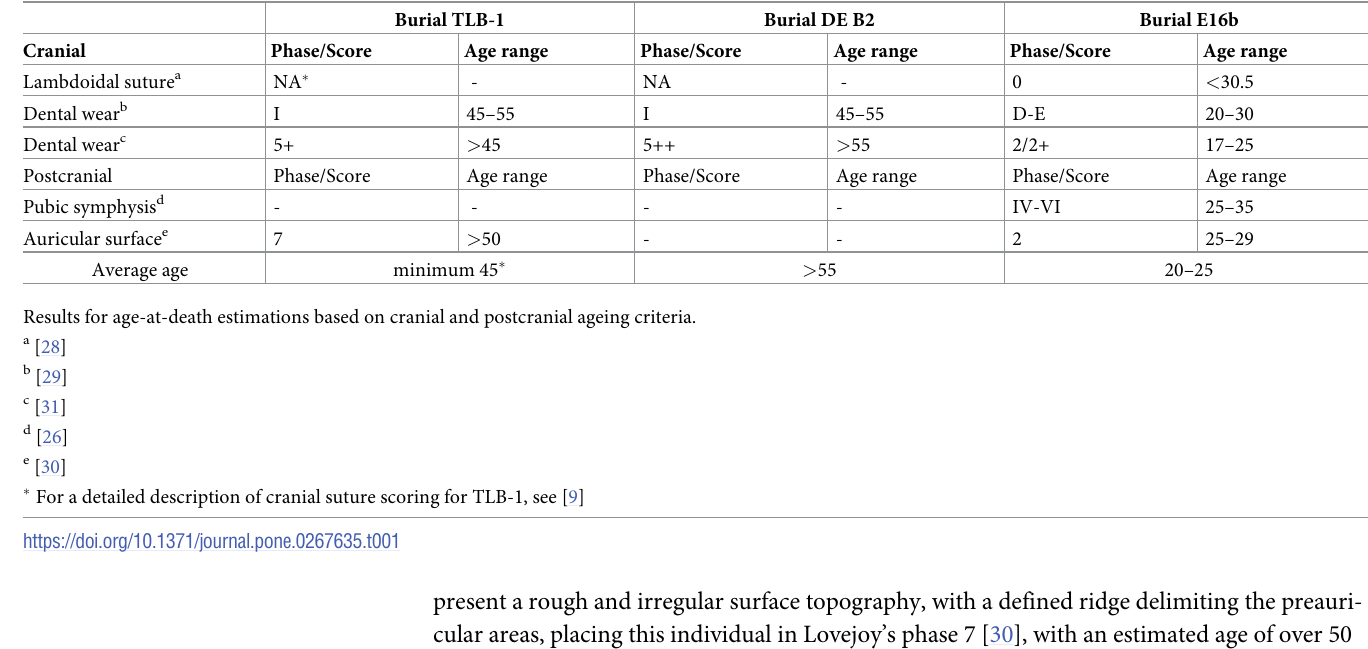
Table 1. Age-at-death Tron Bon Lei